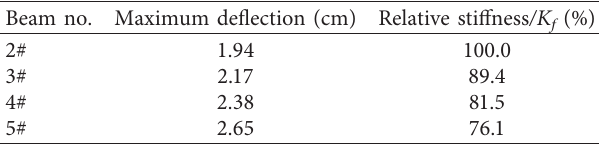
Table 5: Maximum deflection and relative overfire degradation stiffness in midspan under normal loading.